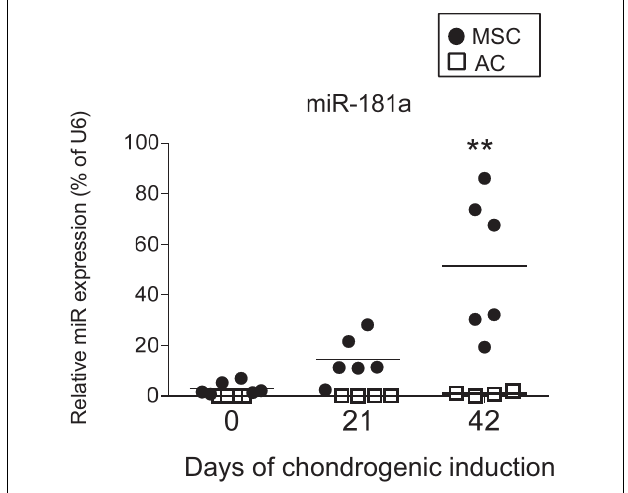
FIGURE 1 | Differential expression of miR-181a between MSC ( N = 6 donors, black circles) and AC ( N = 4 donors, white squares) was monitored at indicated time points during chondrogenic differentiation by qRT-PCR; vertical lines correspond to median values; **p ≤ 0.001 (Two-way ANOVA).